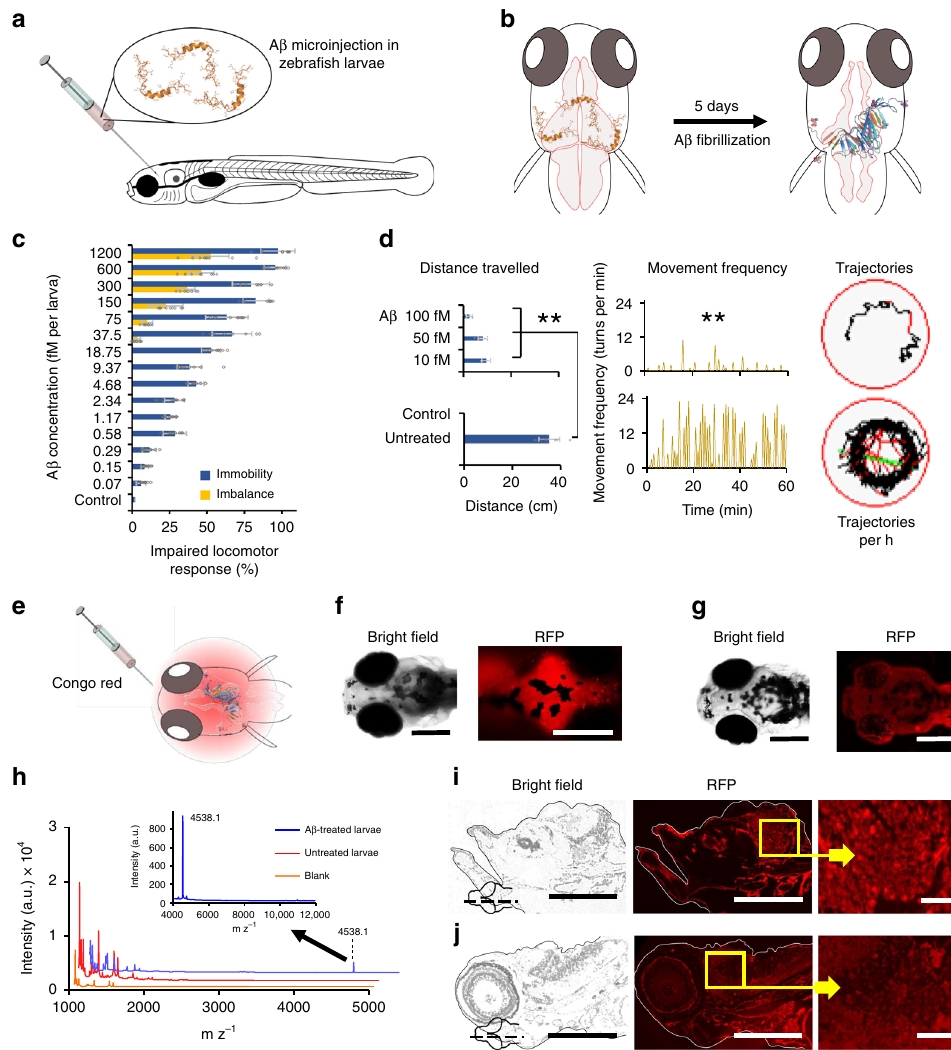
Fig. 3 A β toxicity in zebra fi sh ( Danio rerio ) larvae. a Five-day-old zebra fi sh larvae were treated with A β and developed pathological symptoms ( b ). c Disruptive locomotive behavior was recorded in terms of percentage of larvae who failed to respond upon tapping (blue bars) and unable to maintain horizontal swimming position (orange bars) ( n = 10). d The behavior of the larvae was further recorded on an automated zebra fi sh behavior monitoring system for 1 h at 5 days post A β treatment ( n = 10). Total distance traveled along with movement frequency was signi fi cantly decreased compared to untreated control ( p < 0.005). Representative trajectories of 100 fM A β treated and untreated larvae inside a single well of a 96-well plate, during 1 h of observation. e Five days after A β (100 fM) treatment, larvae were further treated with Congo red (100 fM) via cerebroventricular injection. Whole mount larvae were imaged under the RFP channel 6 h after A β treatment. f Signi fi cant fl uorescence was retained in the cereberal region of larvae on the fi fth day post A β treatment. g Congo red injected in untreated larva was not retained in the cerebral region. h MALDI detection of A β in the brain of zebra fi sh larvae, 5 days post A β injection ( n = 10, Mean ± SD). Five days after cerebroventricular injection of A β , the heads of zebra fi sh larvae were excised after euthanization. The heads were homogenized in Holtfreter ’ s buffer and subjected to MALDI-TOF/TOF analysis. Peak corresponding to A β molecular weight was observed at 4538.1 mz − 1 . Untreated larvae and matrix alone were used as controls. i Congo red-stained thin section (sagittal) of A β treated larvae brain tissue. Bright red spots were observed in the cerebral region of larvae, corresponding to the A β amyloid or plaque formation. j In thin sections of the brain tissue of untreated larvae (negative control), no red spots were observed. Scale bars in all images are 200 µ M, while in i and j inset are 20 µ M. Error bars represent the standard deviation. Source data are provided as a Source Data fi